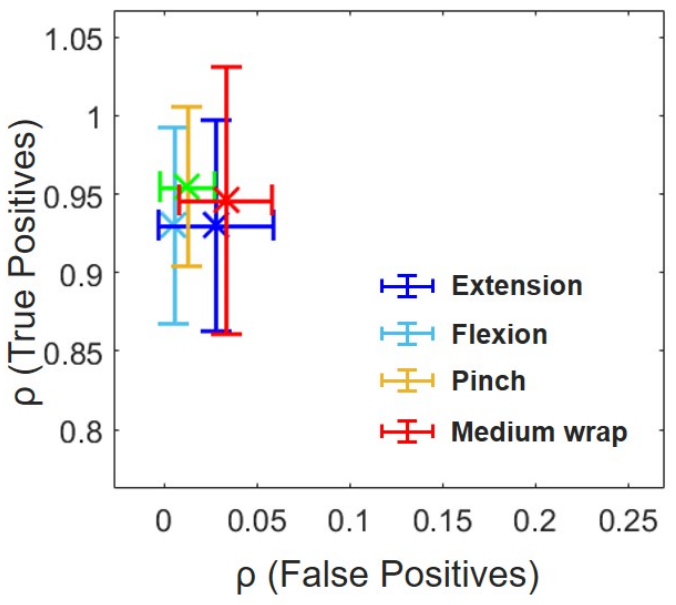
Figure 22. Detection results for the true positive vs. the false positive rate.